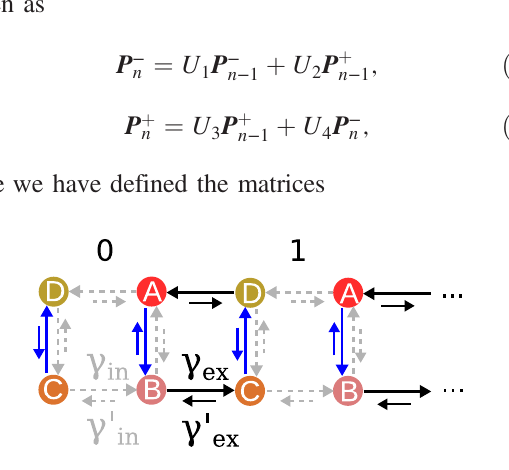
FIG. 11. Schematic of half-periodic geometry. The system is periodic along the vertical direction and open along the horizontal direction. The stationary probability for the four sites belonging to a cell a distance n away from the left edge is given p n p n p n by the four-vector P n ≡ ½ p n (cid:2) T . The solid blue D B C A and γ 0 transitions that fold back along the arrows denote the γ ex ex periodic